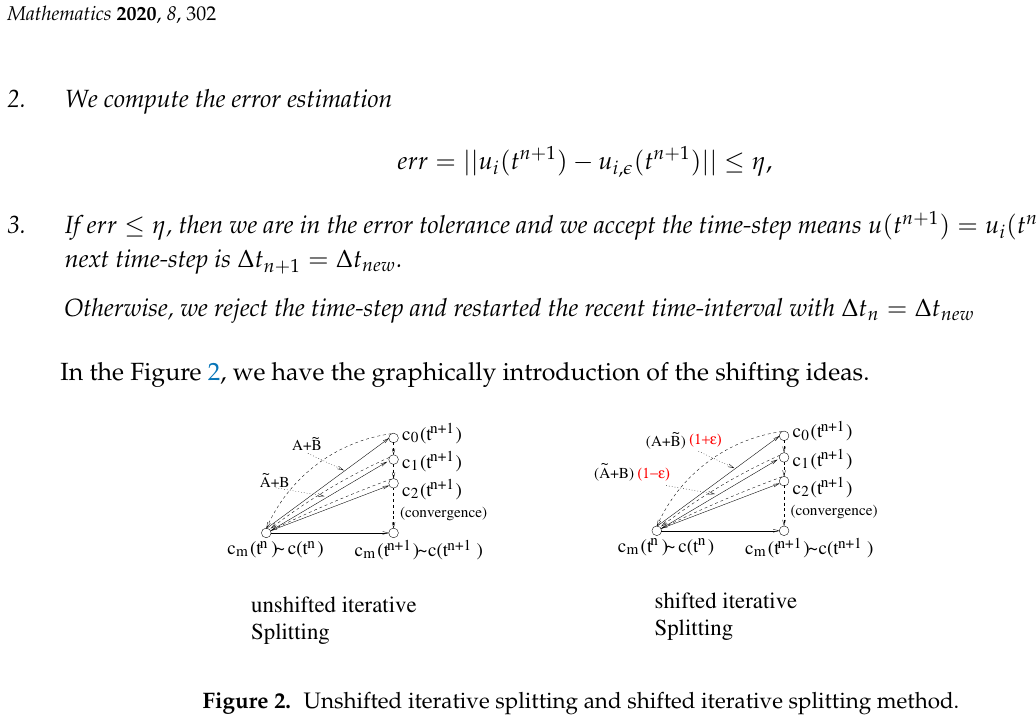
Figure 2. Unshifted iterative splitting and shifted iterative splitting